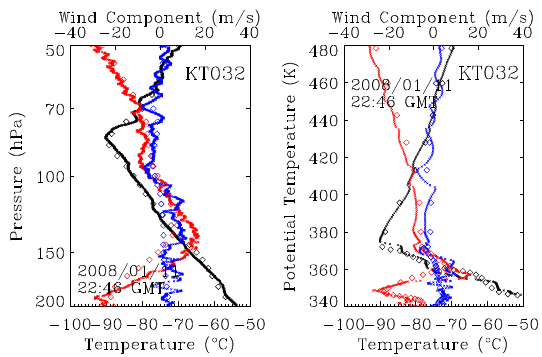
Fig. 3. Profiles of temperature (black) and zonal (red) and meridional (blue) wind components as a function of (left) pressure (hPa) and (right) potential temperature (K) at Kototabang observed on 11 January 2008. Radiosonde observations (densely populated crosses) and corresponding ECMWF analysis interpolated to the station(diamonds)arecompared.